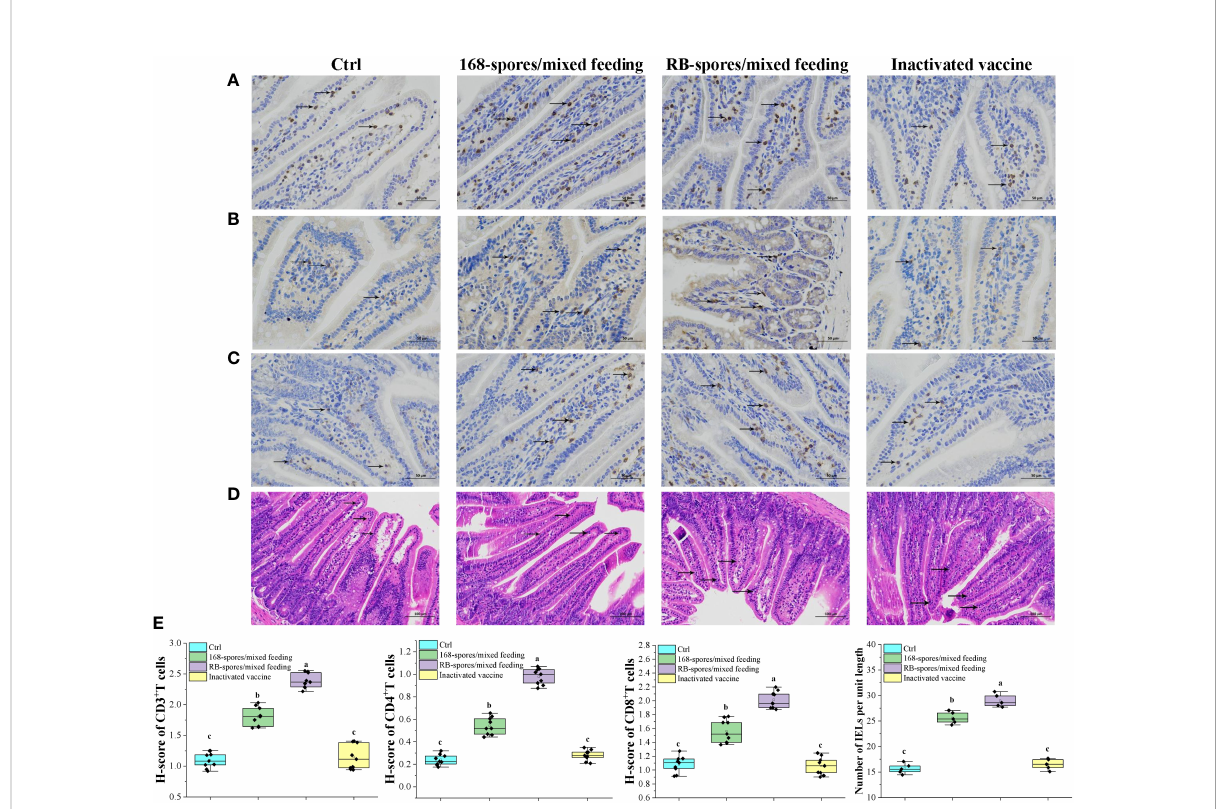
FIGURE 7 The distribution of CD3+, CD4+, CD8+ T lymphocytes and IELs in intestinal mucosa was observed and quantitatively analyzed. (A – C) Distribution of CD3+, CD4+ and CD8+ T lymphocytes in the ileal mucosa, black arrows indicate typical positive cells. Magni fi cation of 400×. (n=9) (D) Distribution of IELs cells in the small intestinal mucosa. IELs are shown by black arrows, which are distributed in the mucosal epithelial layer of the small intestine, with irregular nuclei and darker staining than epithelium. Magni fi cation of 200×. (n=5) (E) The number of CD3+, CD4+ and CD8+ T lymphocytes in the intestinal mucosa, expressed as H-score. And the number of IELs per unit length in the intestinal villi. H-score is a value between 0-300, the larger the value, the stronger the comprehensive positive intensity and the more positive cells. Data are presented as means ± standard deviation. One-way ANOVA followed by a Friedman test was performed, bars with different letters indicate a signi fi cant difference ( P <